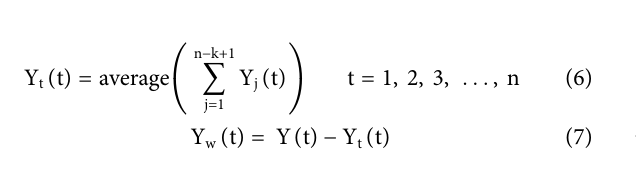
FIGURE 4 | Distribution of occurrence probability for each level of reduction